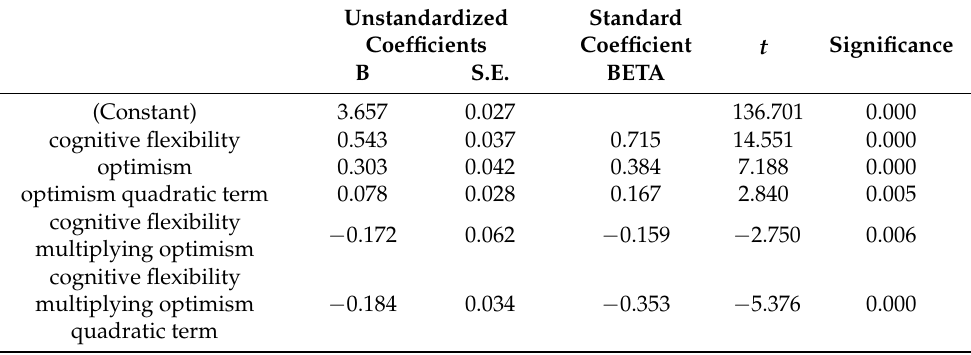
Table 8. Moderating role of optimism in the relationship between cognitive flexibility and en- trepreneurship